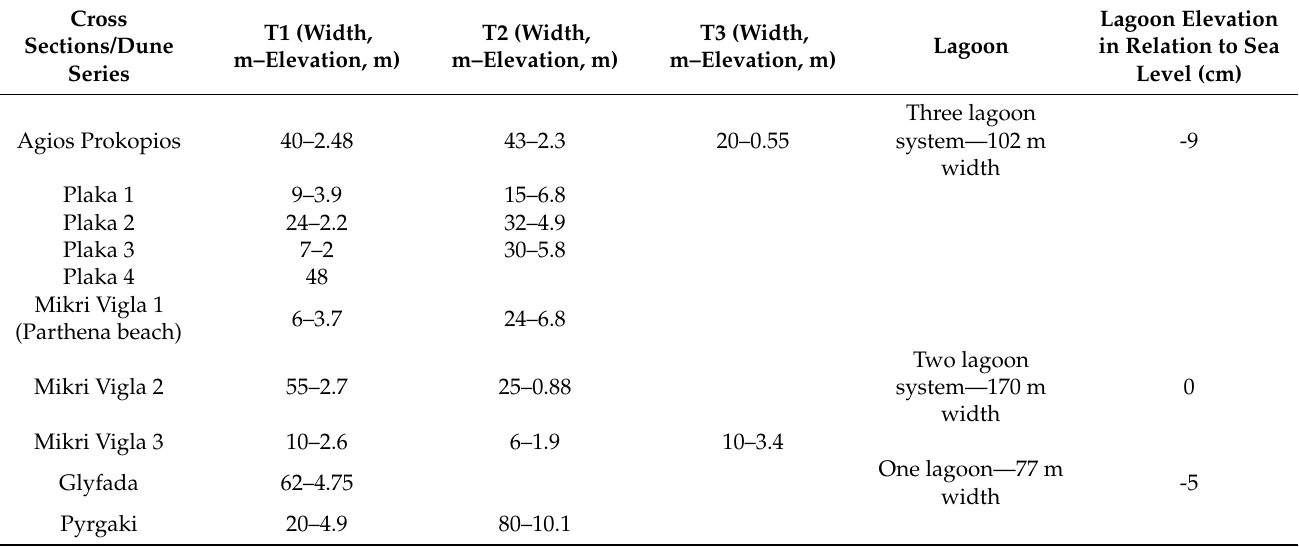
Table 1. The main characteristics of dunes and lagoons of the studied